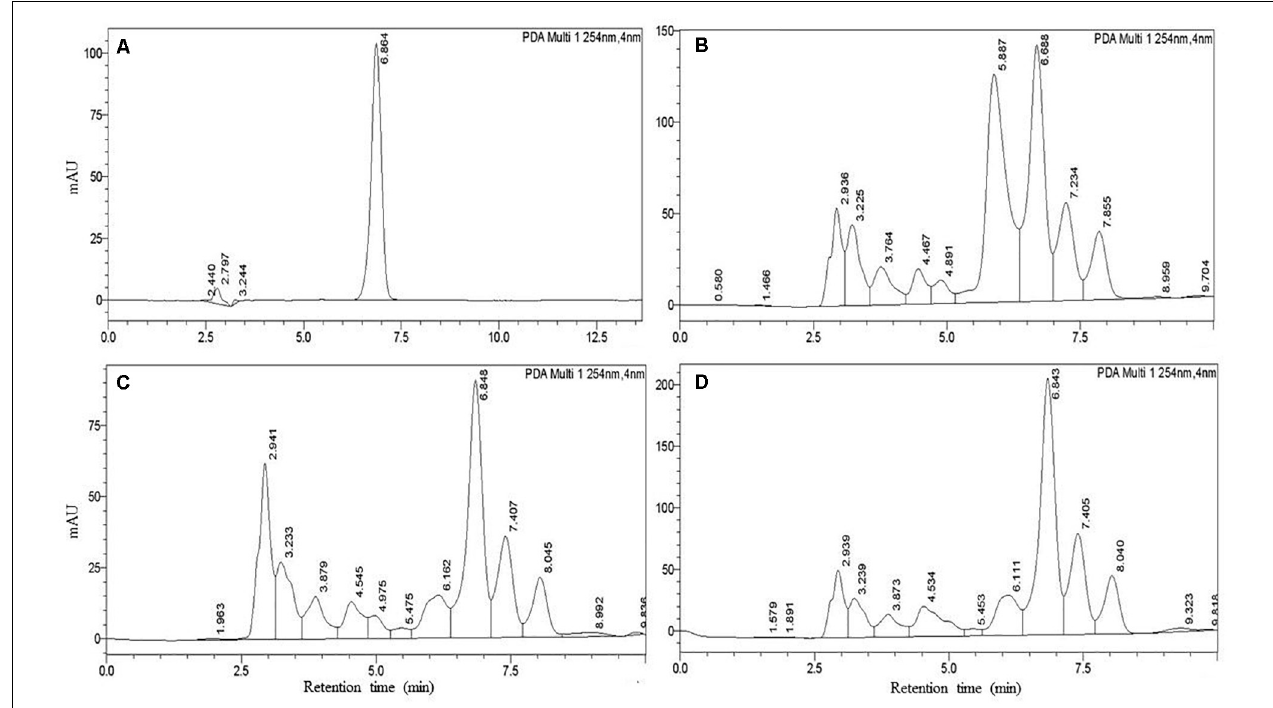
FIGURE 6 | Detection of IAA using HPLC. (A) IAA standard (50 µ g mL − 1 ), (B) P. cedrina ESR12, (C) P. chlororaphis ESR15, and (D) B. aryabhattai ESB6.